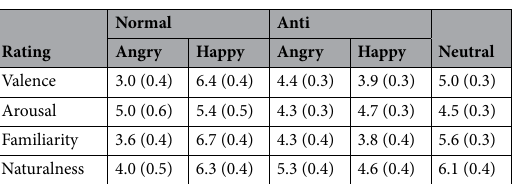
Table 3. Mean (± SE ) subjective ratings in temporal-lobe-resected patients.